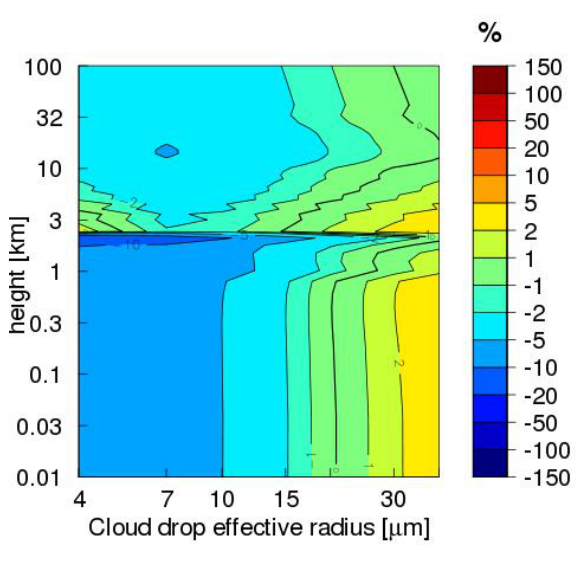
Figure 18. As for Fig. 16 but for IFS-Nielsen vs. HS-DISORT.